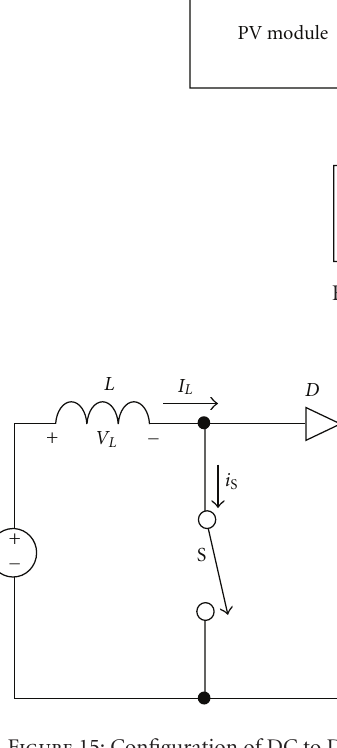
Figure 15: Configuration of DC to DC boost converter.